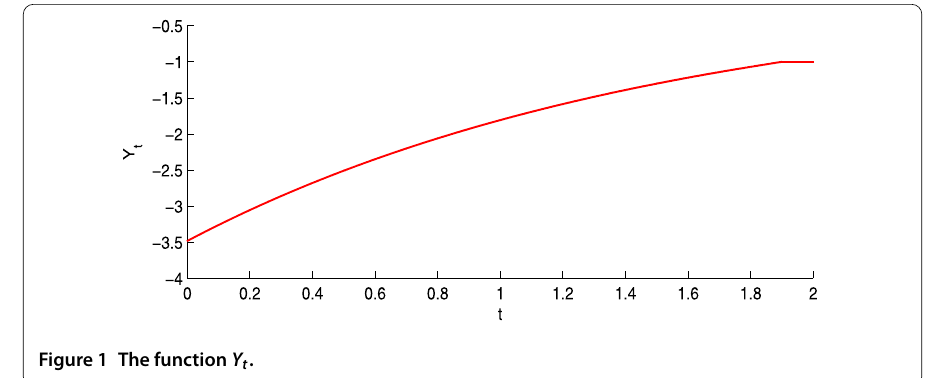
Figure 1 The function Y t